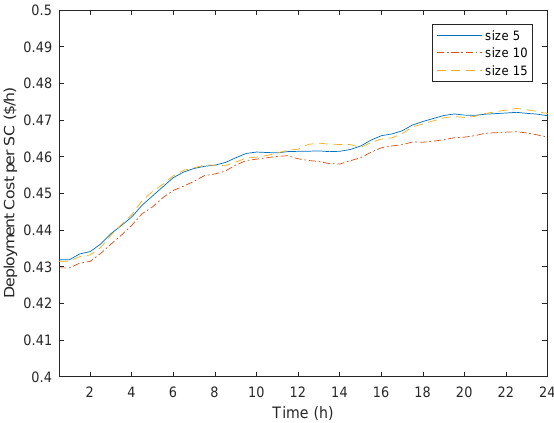
Figure 7. Impact of the Tabu list size in Tabu